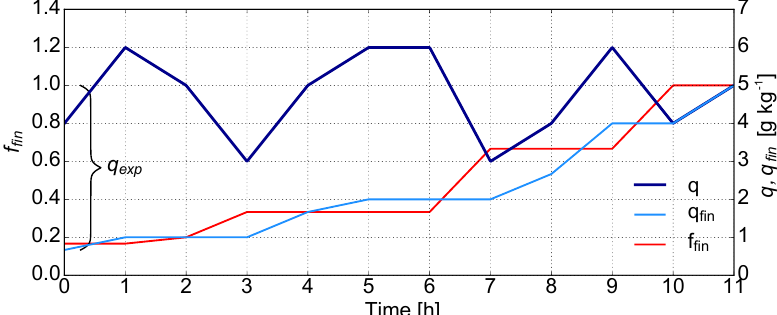
Figure 6. Time series of q (dark blue line), q fin (light blue line), and f fin (red line) along a hypothetical trajectory with N = 11. The total fraction of explained moisture ( q exp ) corresponds to 1 − q 0